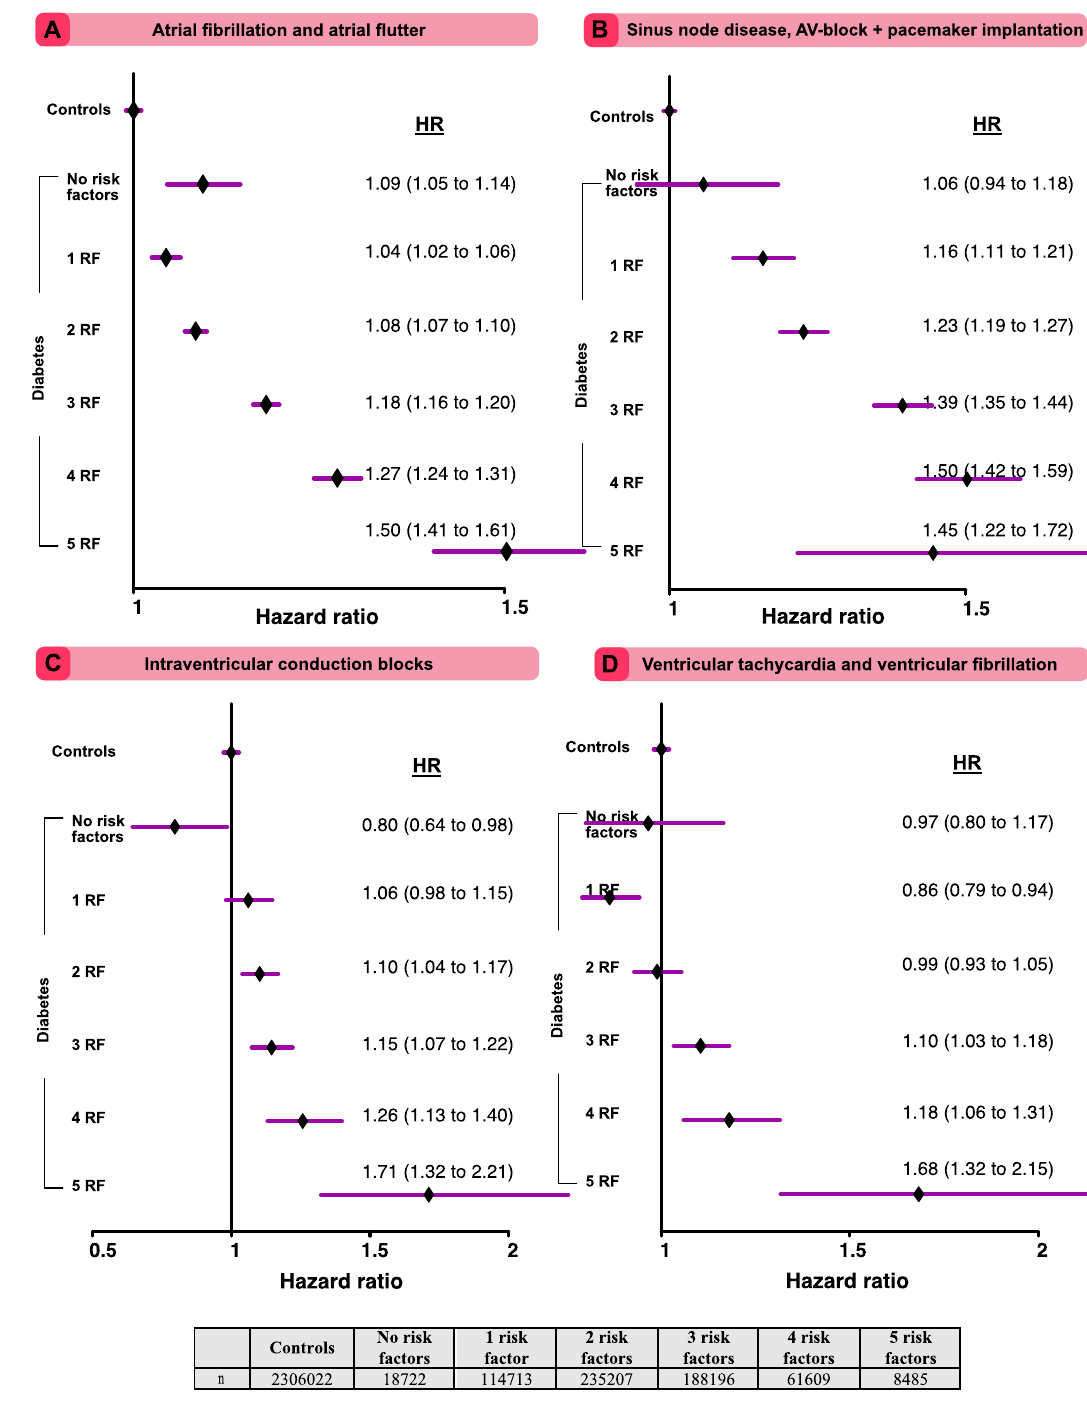
Figure 4. Adjusted hazard ratios for cardiac arrhythmias, according to number of risk factor variables outside target range among patients with type 2 diabetes, as compared to matched controls. Hazard ratios shows the excess risk of each outcome among patients with diabetes, compared to matched controls from the general population, according to number of risk factors (scale, none to five) that were outside therapeutic ranges. Tables displays number of study participants in each risk factor category. The dark lines indicate the hazard function and the shaded areas 95% confidence